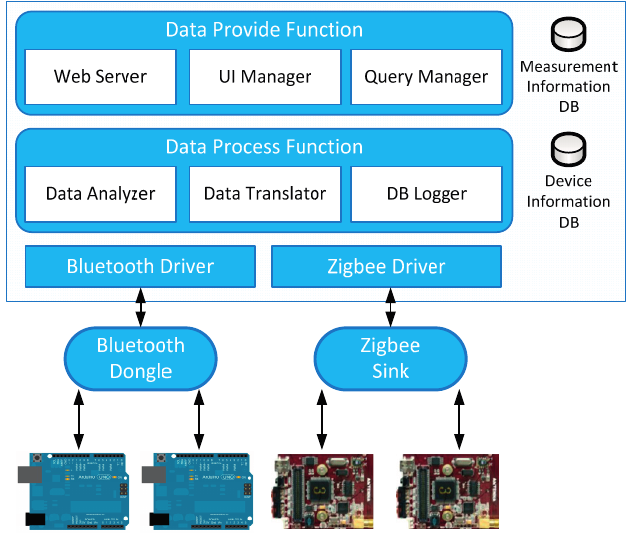
Figure 5. Implementation architecture of the RESTful smart space gateway